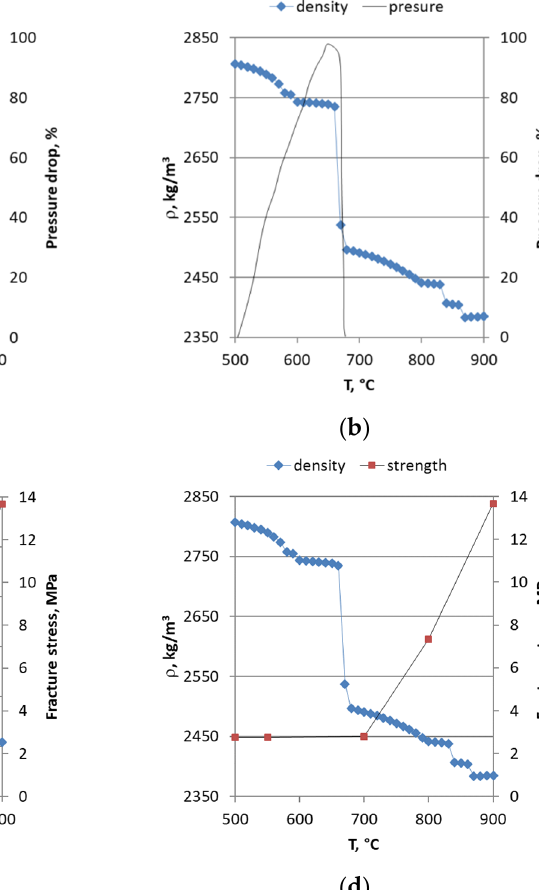
Figure 8. Barley straw: ( a ) Specific heat (c p ) and pressure drop as a function of temperature; ( b ) den- sity ( ρ ) and pressure drop as a function of temperature; ( c ) specific heat and fracture stress as a function of temperature; ( d ) density and fracture stress as a function of